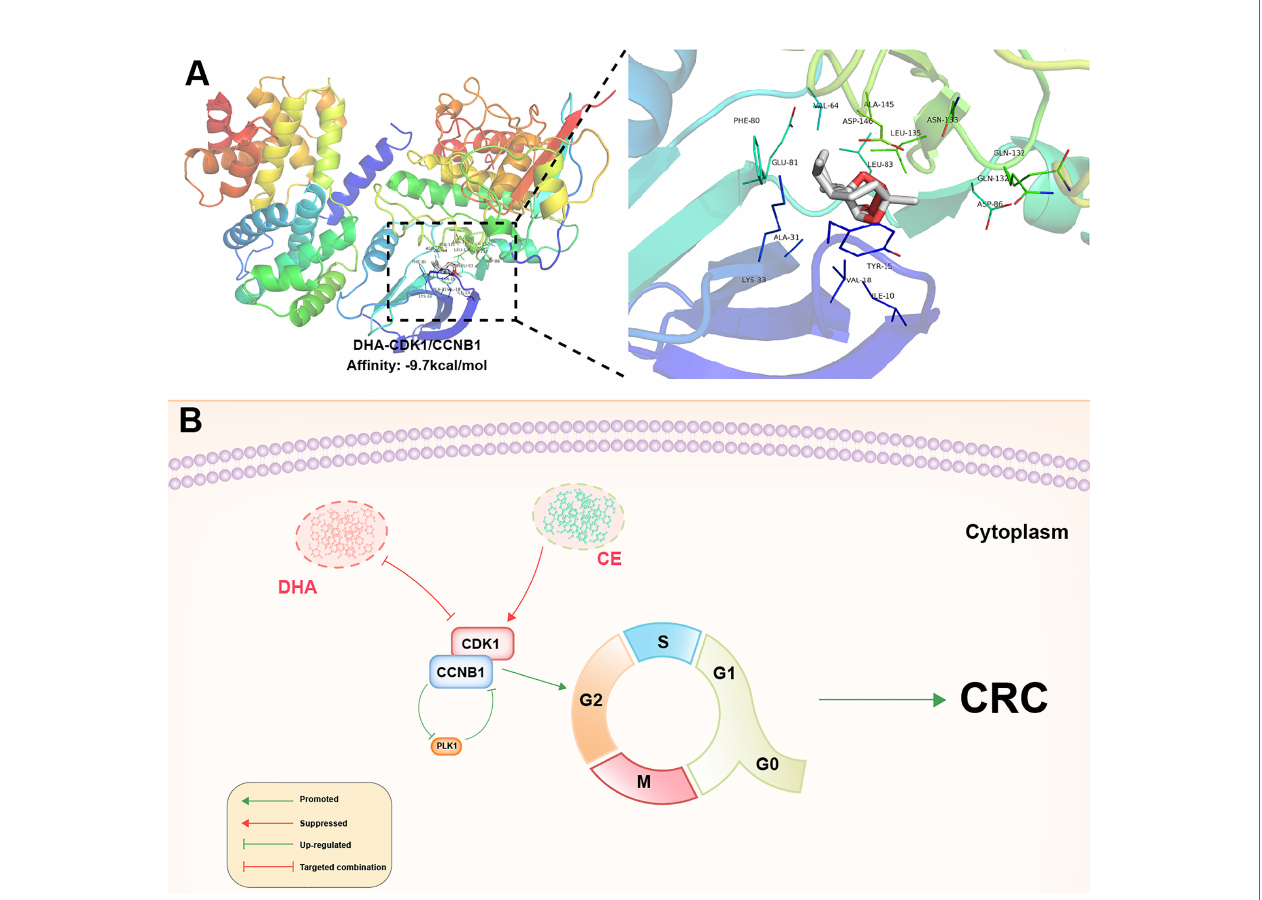
FIGURE 7 | Molecular mechanisms of DHA in CRC. (A) Molecular docking of DHA into the protein crystal of the CDK1/CCNB1 complex. (B) DHA suppressed the tumorigenesis and cycle progression of CRC by targeting CDK1/CCNB1/PLK1 signaling. DHA, dihydroartemisinin; CRC, colorectal